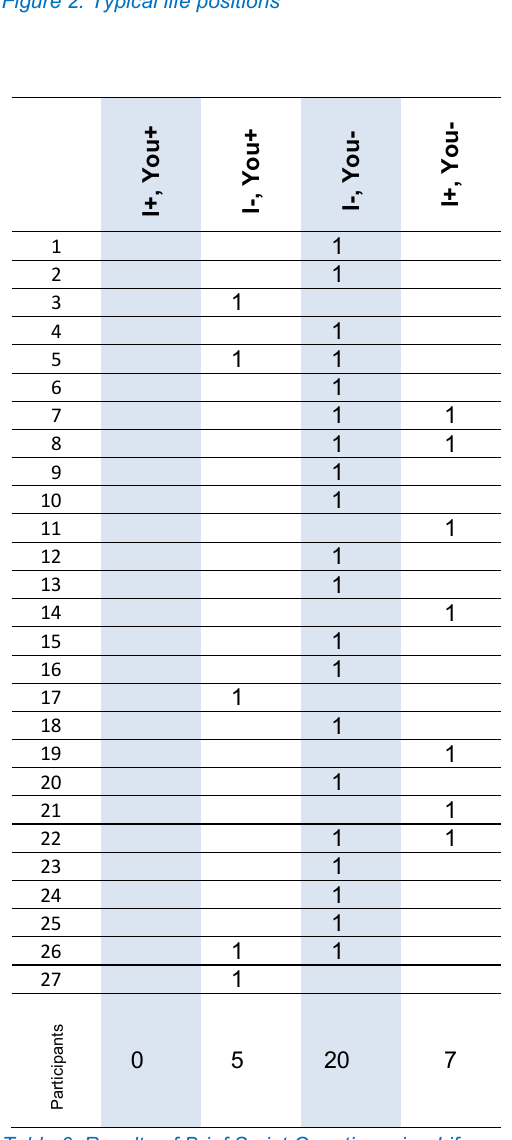
Figure 2. Typical life positions